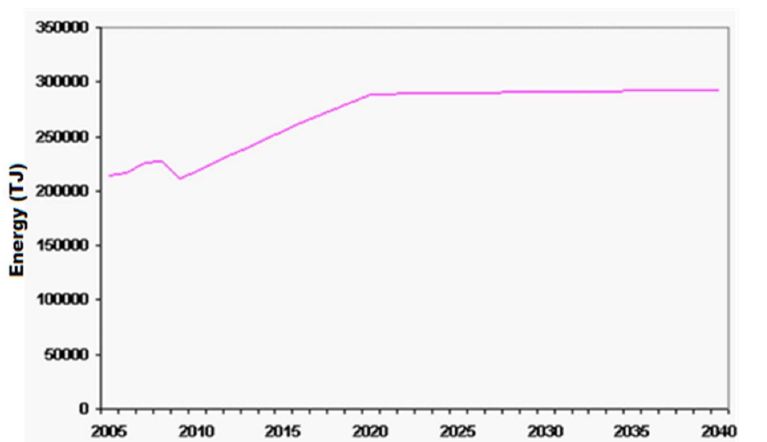
Figure 12. Estimated electricity demand according to the BAU scenario.